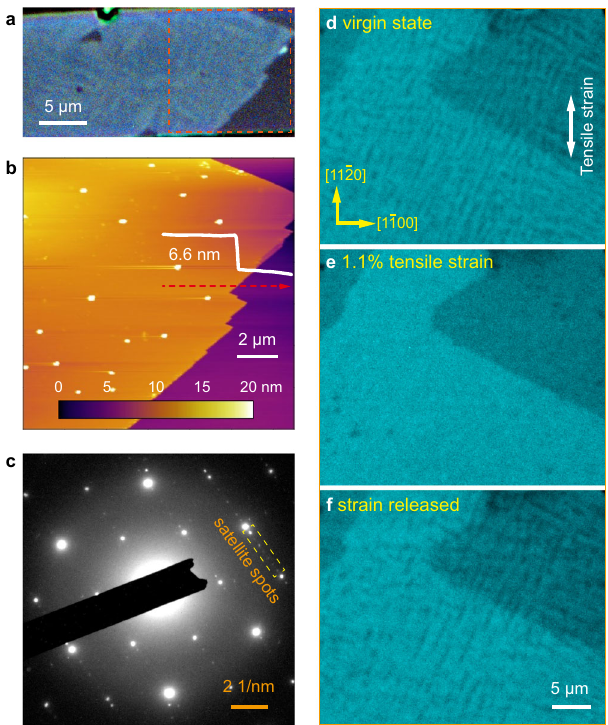
Fig. 5 2D ferroelasticity in ultrathin β ’ -In 2 Se 3 fl akes grown by CVD. a Polarized-light image showing the presence of domain structure in an as- grown ultrathin fl ake. b AFM image of the area highlighted by the orange box in a . The inset line pro fi le indicates a thickness of ~6.6 nm. c SAED pattern of an ultrathin β ’ -In 2 Se 3 fl ake, revealing the preservation of superstructure indicated by the satellite diffraction. d – f Polarized-light images showing ferroelastic domain switching in an ultrathin β ’ -In 2 Se 3 fl ake upon applying the tensile